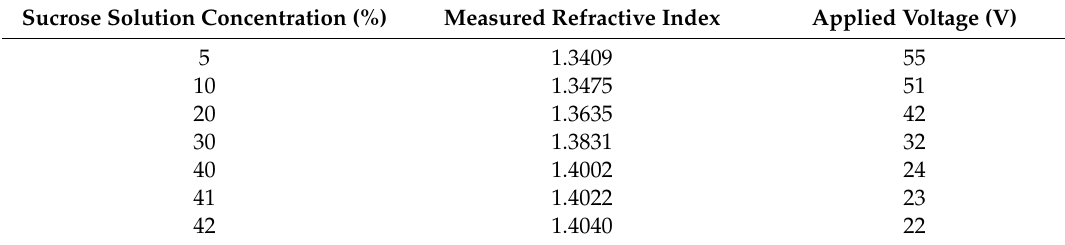
Table 2. Refractive index with di ff erent concentrations of sucrose solution.